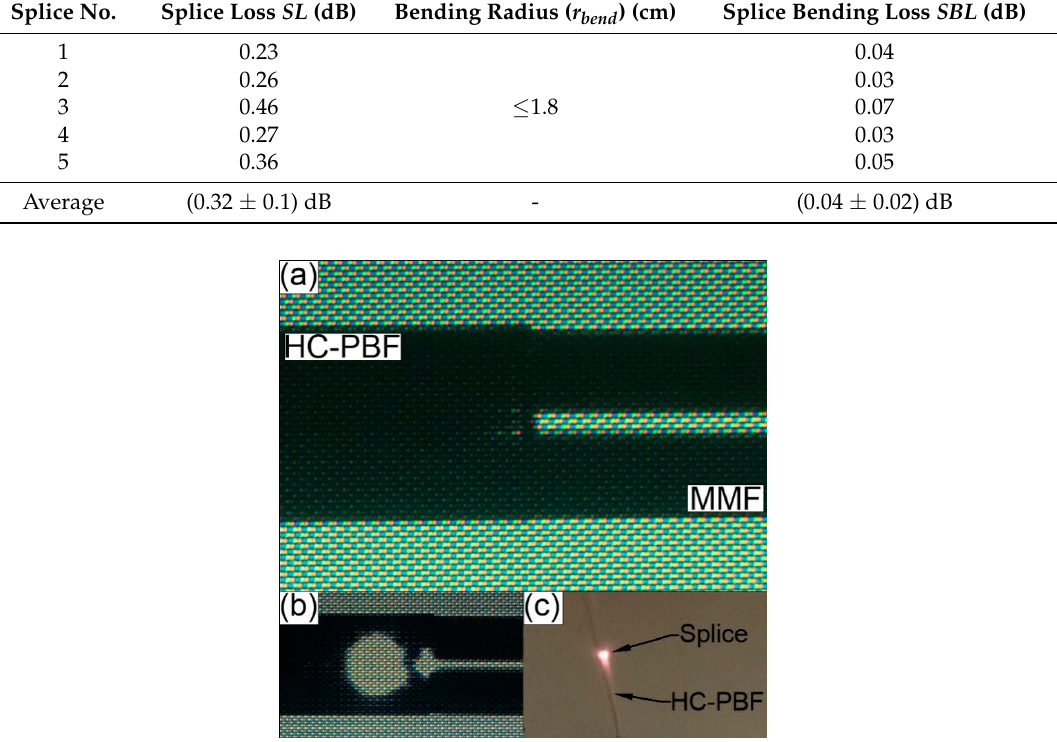
Figure 2. ( a ) Splice between the HCPBF and MMF. ( b ) Scattering and reflection of the transmitted λ